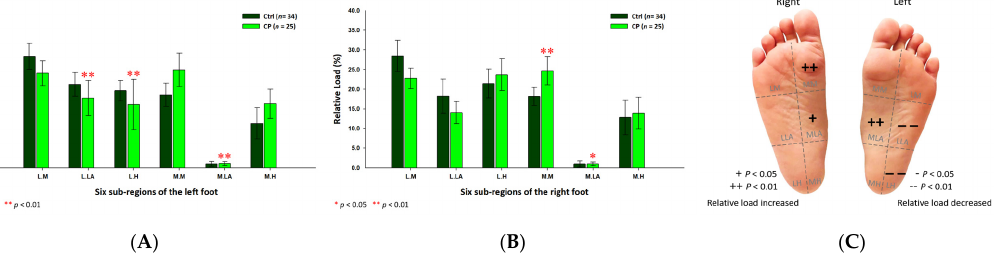
Figure 4. The percentage of six subregional relative loads of ( A ) left and ( B ) right feet in female students during static stance. The changes in pressure distribution are illustrated in ( C ) foot plantar diagram. Significant differences between the female control group and the female CP group were determined as * p < 0.05 and ** p < 0.01.